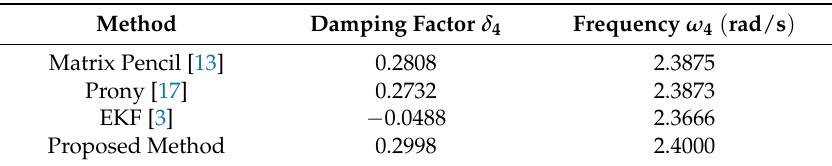
Figure 10. Comparisons of average estimation errors. Table 3. Identified results of different methods.